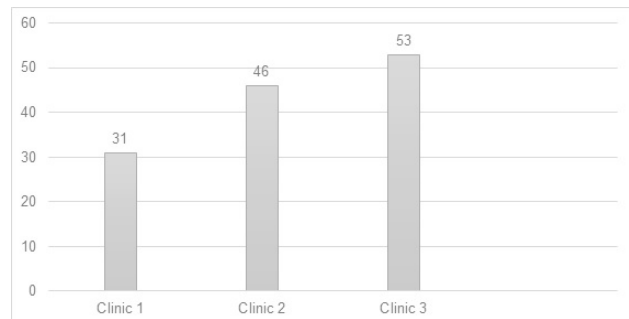
Fig. 2 - Correlation CFU / mL between the clinics.